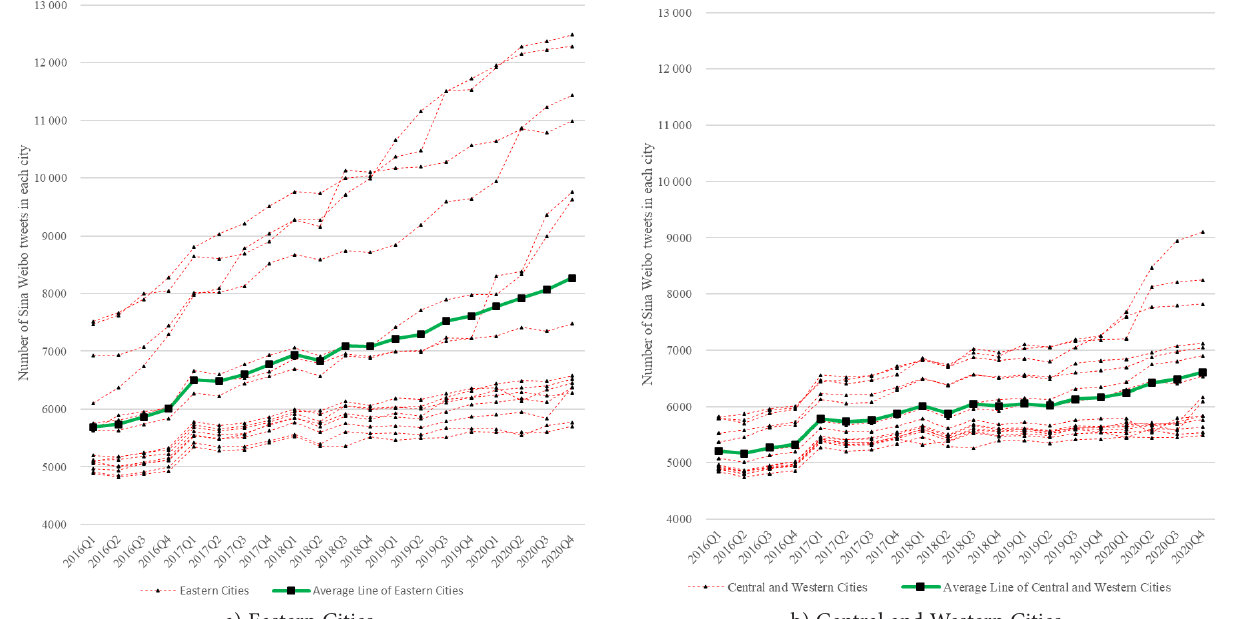
a) Eastern Cities b) Central and Western Figure 2. The number of quarterly Sina Weibo tweets in 30 cities in mainland China